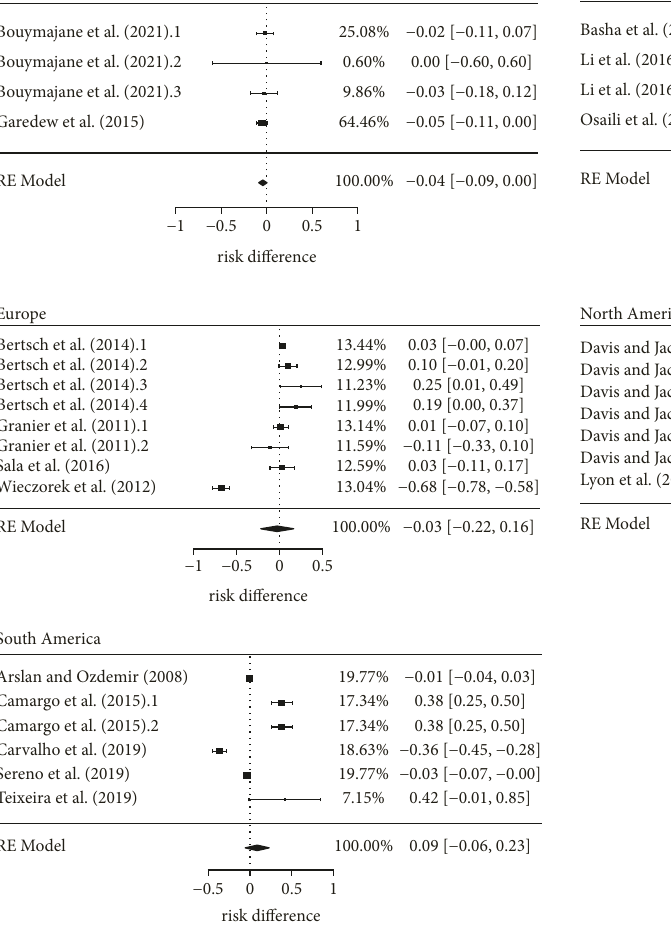
Figure 5: Risk difference of antimicrobial resistance to first- and second-line drugs in Listeria monocytogenes by study location. Table 2: Estimates and main statistics of the risk difference of antimicrobial resistance in Listeria monocytogenes by study